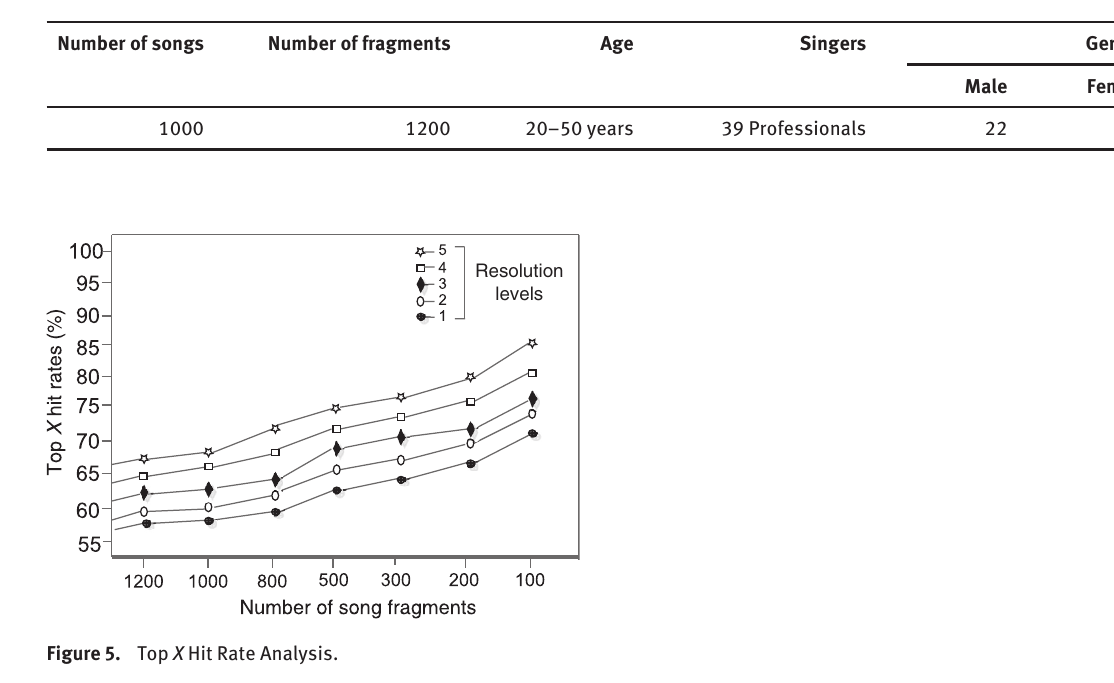
Table 1. Summary of Training Database.